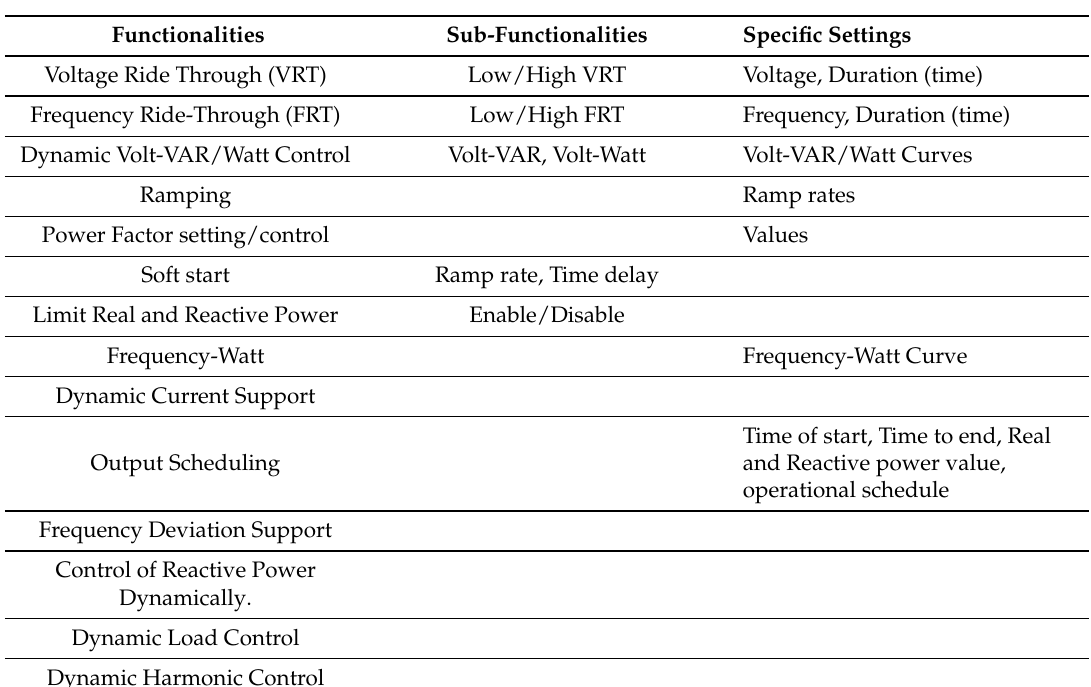
Table 2. Smart Inverter